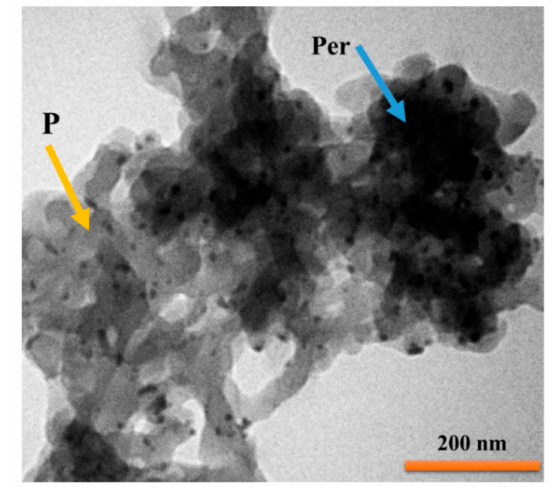
Figure 5. TEM image of the catalyst.